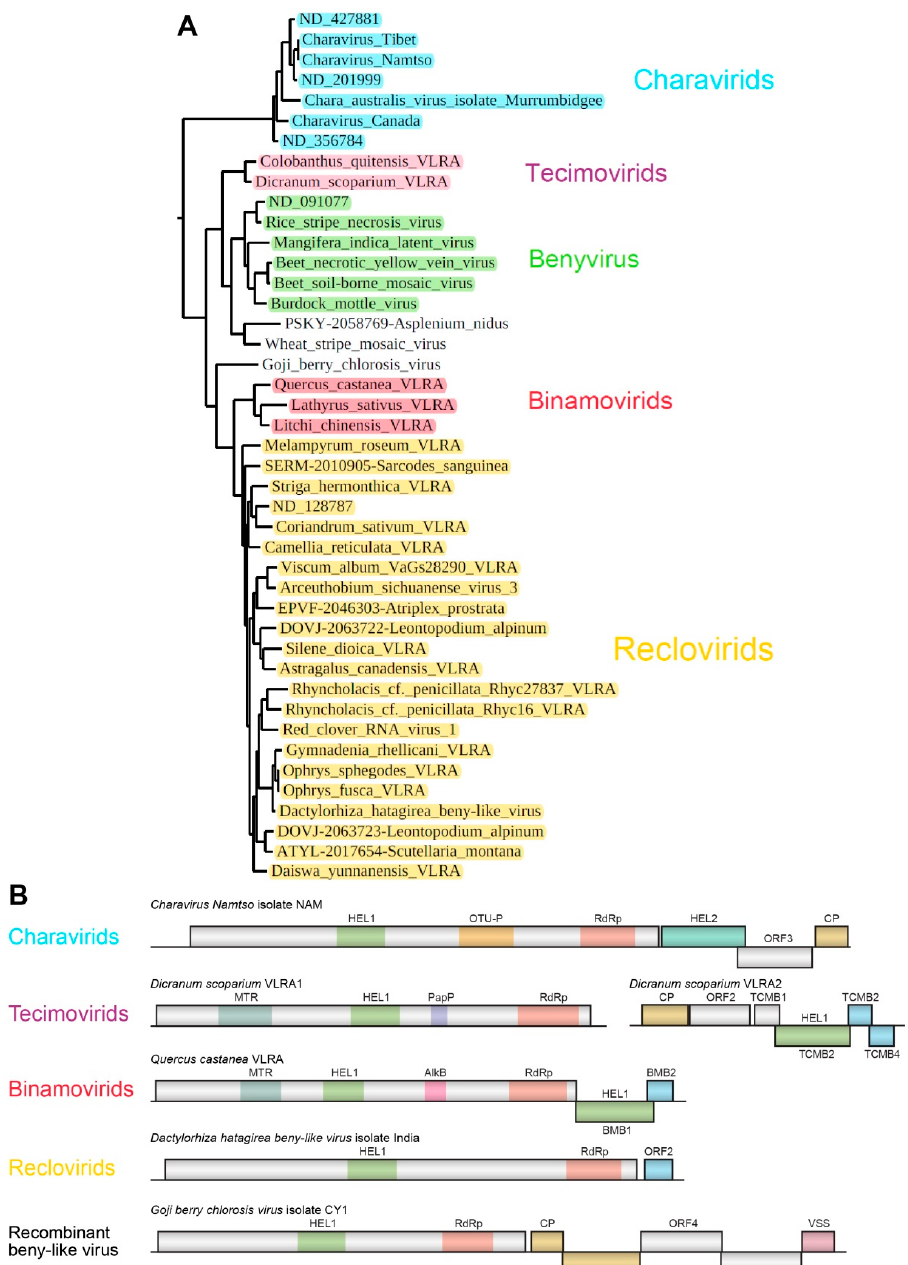
Figure 5. ( A ) Phylogenetic subtree of the whole tree of RdRp domains from Figure 2 showing a large cluster of Viridiplantae-specific viruses and derived from the aligned amino acid sequences of